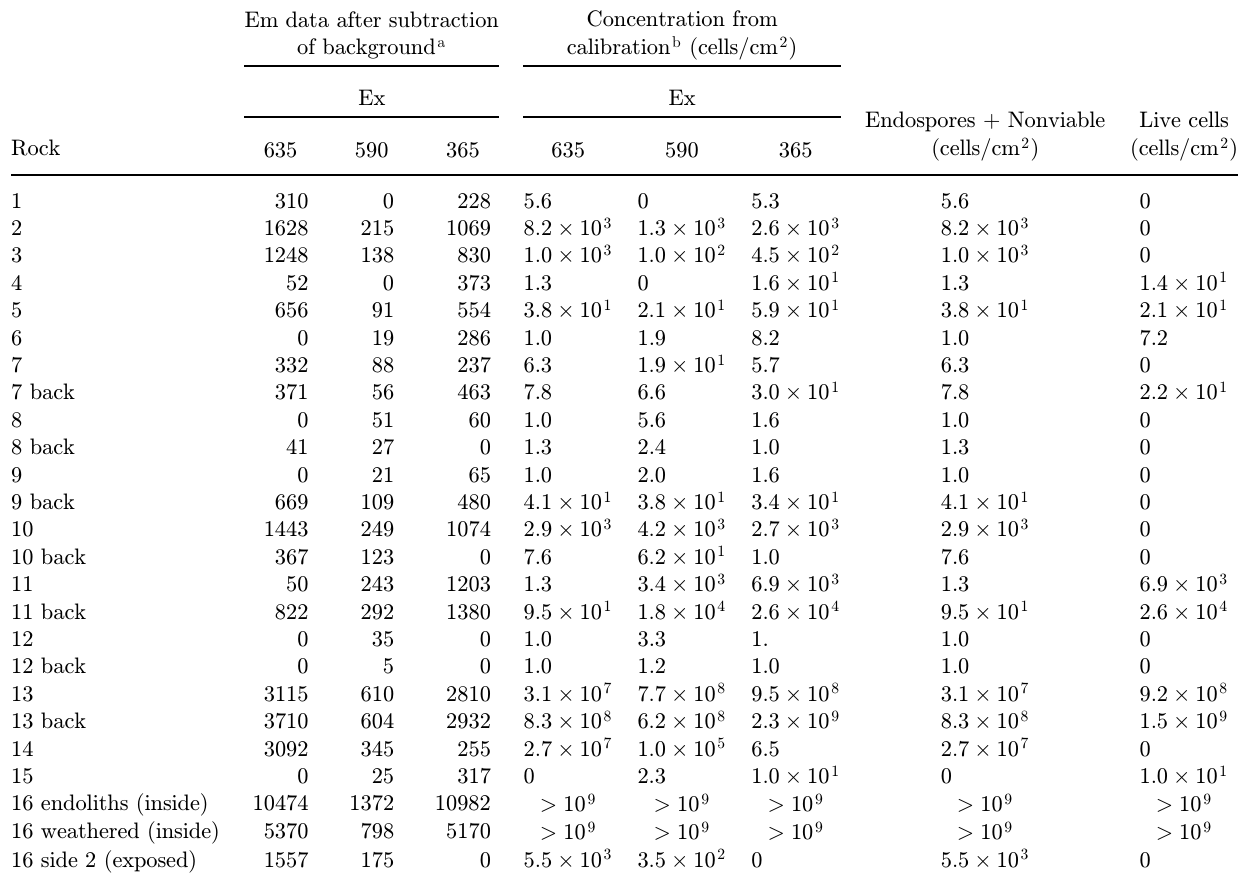
a Values are relative °uorescence units. b See Fig. 3 for representative